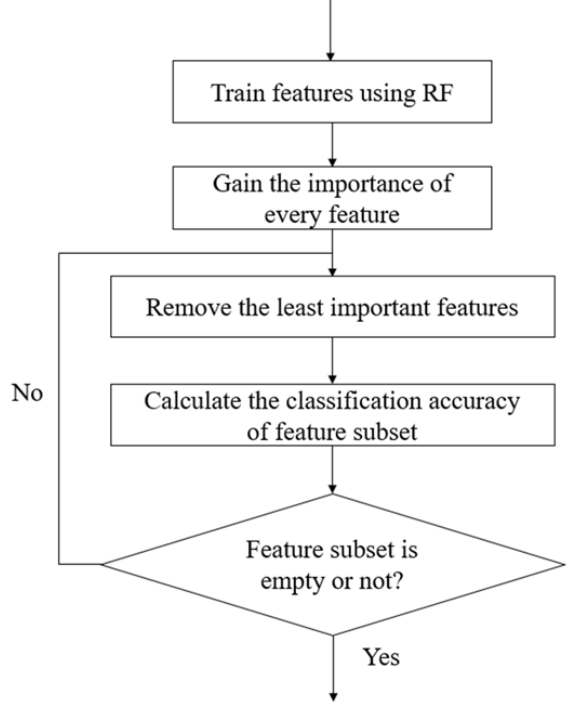
Figure 2. The main procedure of the recursive feature elimination (RFE) method.